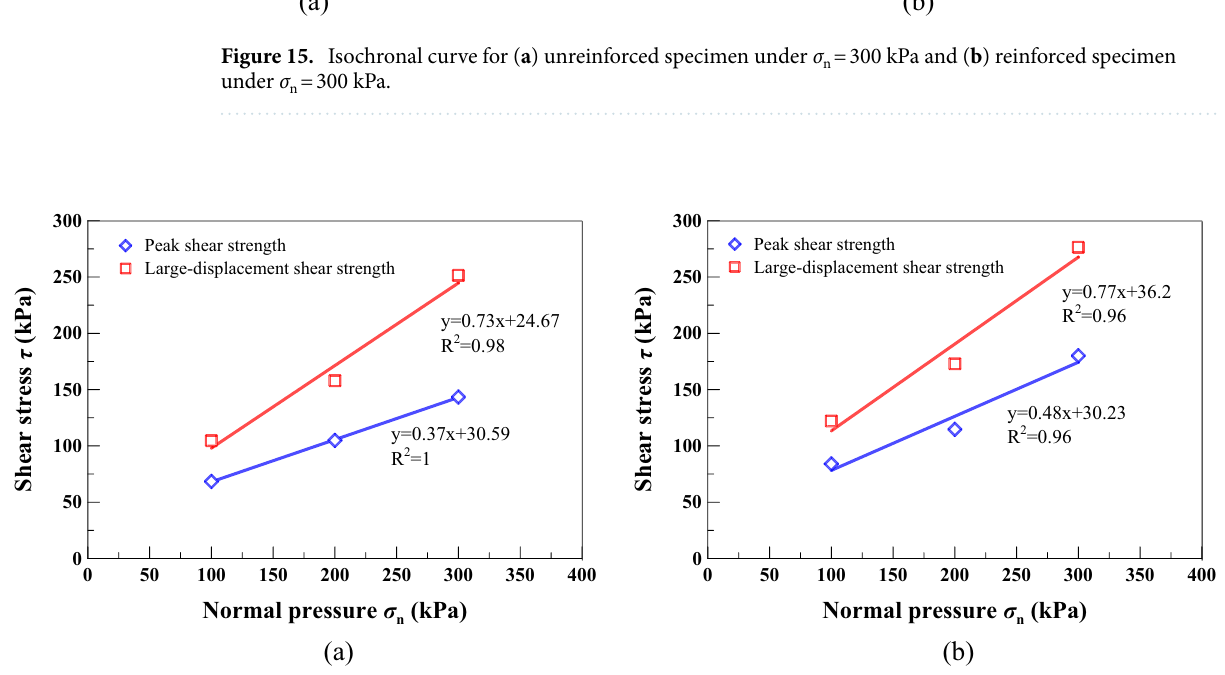
Figure 16. Shear strength envelopes: ( a ) unreinforced specimens and ( b ) reinforced